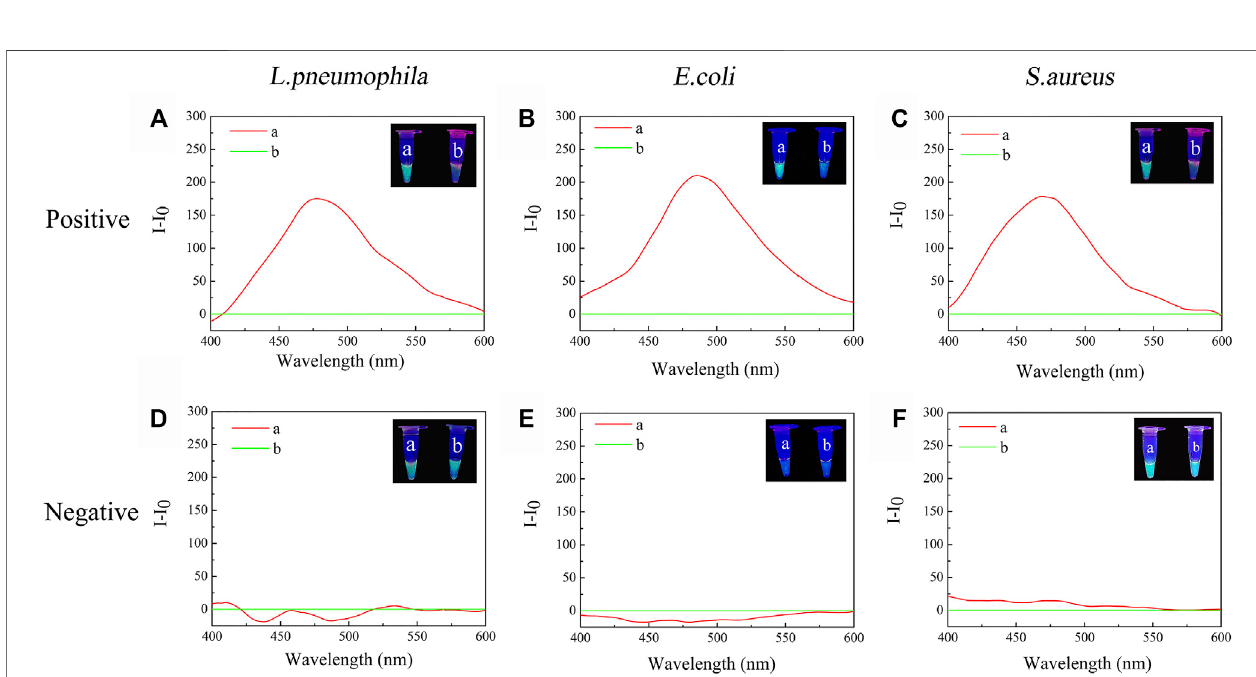
FIGURE2| The visual discriminationresults under UV irradiation (365 nm)and PL spectra ( λ ex. (cid:1) 350 nm) of (A) L. pneumophila positive sample; (B) E.coli positive sample; (C) S.aureus positive sample; (D) L. pneumophila negative sample; (E) E.coli negative sample; (F) S.aureus negative sample (a: +TTAPE, b: +TTAPE